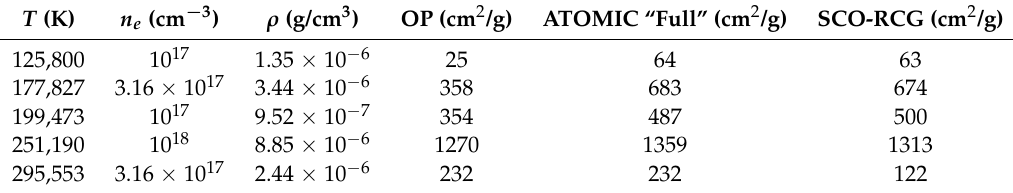
Figure 7. Comparison between SCO-RCG and ATOMIC “full” ( left ) and “n5” ( right ) computations [39–41] of iron opacity at T = 23 eV and ρ = 2 mg/cm 3 . The ATOMIC calculations were kindly provided by J. Colgan. Table 1. Values of Rosseland mean opacity calculated by OP, ATOMIC and SCO-RCG codes for conditions of stellar envelopes.